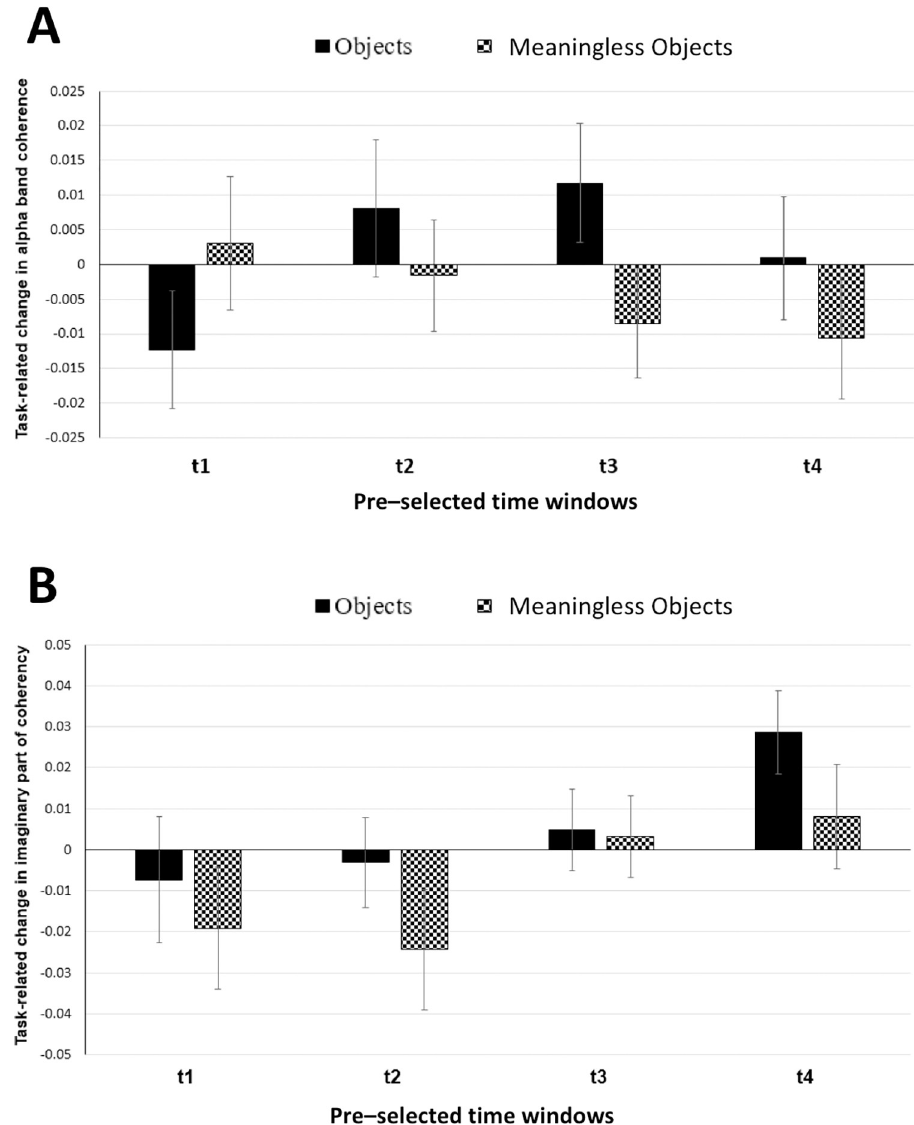
Fig 4. (A) Task-related change in alpha band coherence averaged for four electrode pairs of interest (TP7-TP8, TP7-P8, P7-TP8 and P7-P8) pairs and plotted for four different time windows. Solid black bars represent object stimuli; checked bars represent meaningless object stimuli. t1 = 0–500 ms; t2 = 250–750 ms; t3 = 500–1000 ms; t4 = 750–1250 ms. Error bars are SEM. (B) Task-related change in imaginary part of coherency for alpha band averaged for four electrode pairs of interest (TP7-TP8, TP7-P8, P7-TP8 and P7-P8) and plotted for four different time windows. Solid black bars represent object stimuli; checked bars represent meaningless object stimuli. t1 = 0–500 ms; t2 = 250–750 ms; t3 = 500–1000 ms; t4 = 750–1250 ms. Error bars are SEM. not stimulus (F(1, 10) = 0.068, p = 0.799) or stimulus x direction interaction (F(1,10) = 1.374, p = 0.268). Although left-to-right causality was observed to be more than right-to-left causality for both object and meaningless object stimuli, post-hoc pairwise comparisons using paired t test showed that left-to-right directional connectivity was significantly higher only for object stimuli (t(10) = 2.605, p = 0.026) but not for meaningless objects (t(10) = 1.197, p = 0.259).